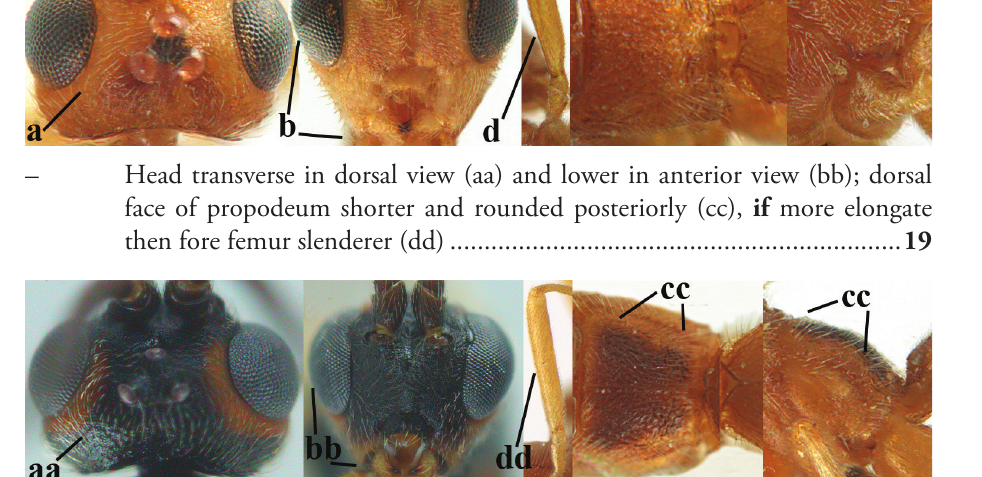
Head subglobose in dorsal view (a) and high in anterior view (b); dorsal face of propodeum long and (slightly) angularly protruding postero-laterally (c); fore femur stout (d); [antennal segments of ♀ 28–35, stout; strongly sexually dimorphic, male with large ocelli and slender antennal segments and antenna with 39–41 segments; body completely yellowish; length of antenna of ♀ 0.9–1.1 × fore wing, longer in ♂ ; second submarginal cell of fore wing rather narrow] ..................................................................... A. curticornis nom. n.